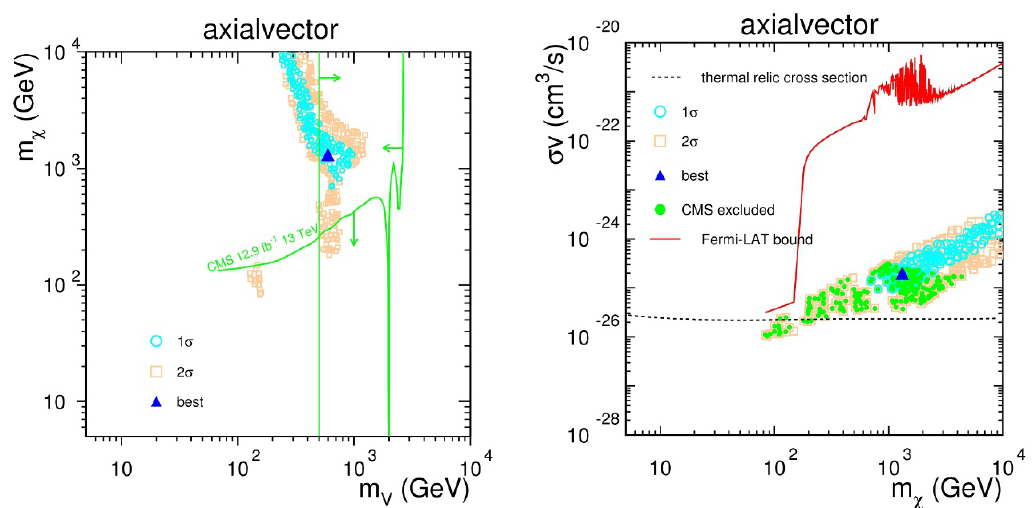
Figure 6 . Left: the AMS-02 favored region of masses ( m (cid:31) vs. m V ) in the simpli(cid:12)ed dark matter model with an axialvector mediator we consider. The LHC exclusion limits are from refs. [41, 42] and [43]. Right: the AMS-02 favored region of cross sections ( (cid:27)v vs. m (cid:31) ).